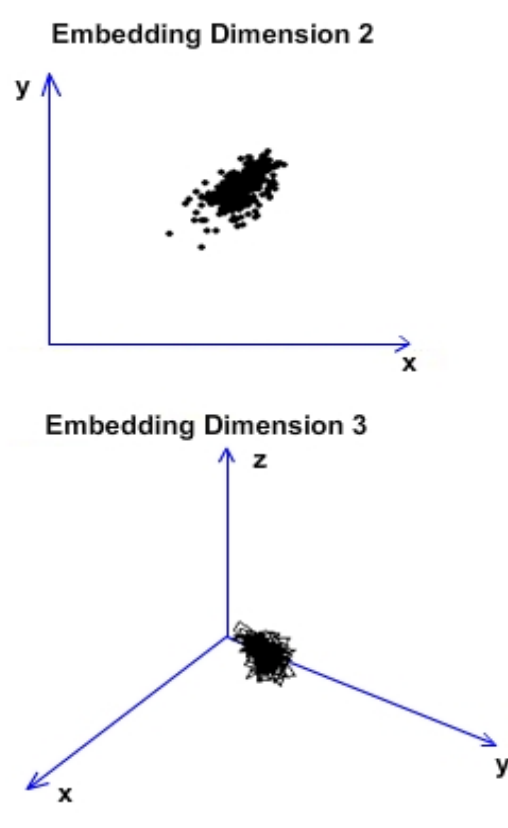
Figure 14. Attractor reconstruction from Figure 13.